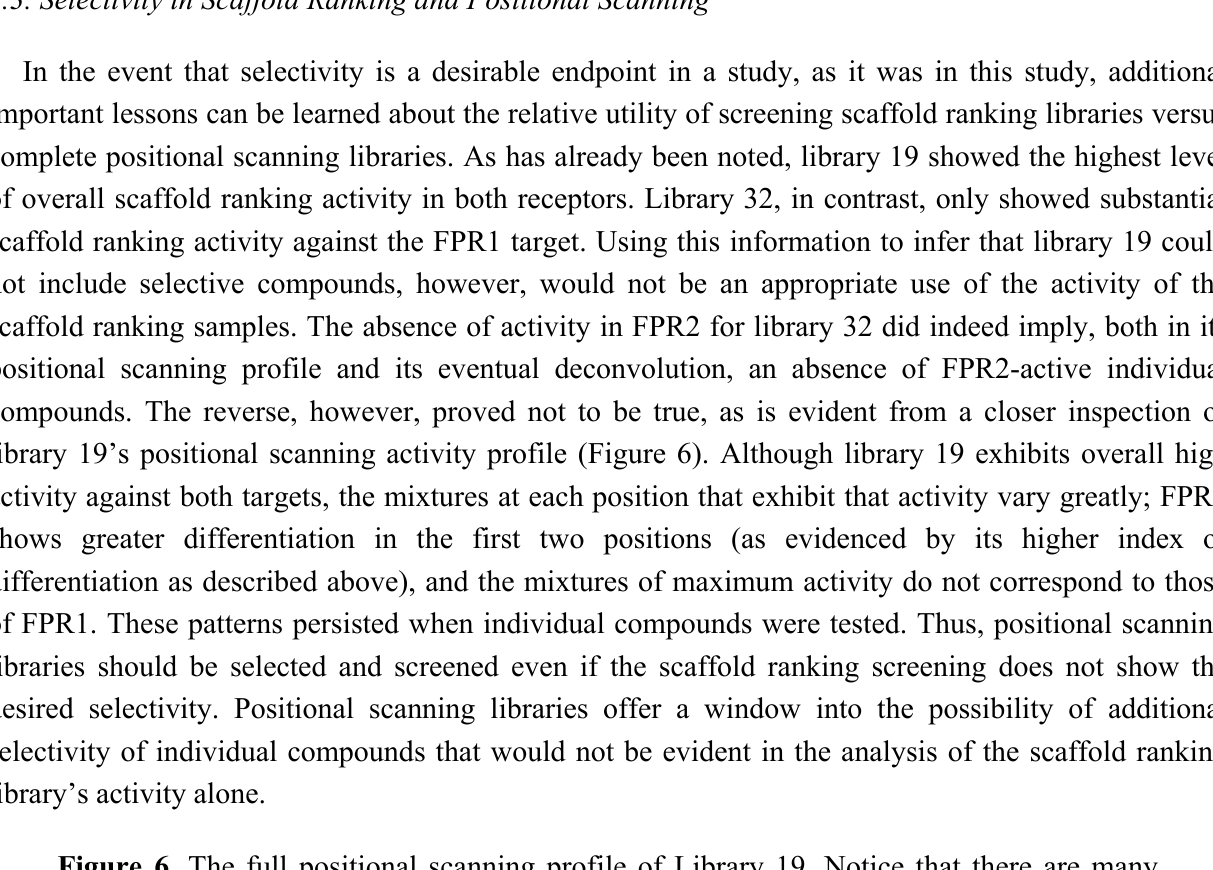
Figure 6. The full positional scanning profile of Library 19. Notice that there are many instances of different mixtures among the most active at the FPR1 target not being active at the FPR2 target, and vice versa. This indicates the potential selectivity that was eventually